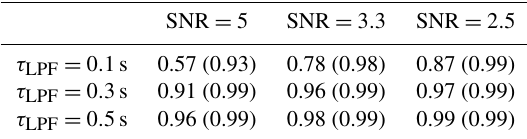
Table 1. Results of the noise removal procedure applied in the power spectra approach following Ibrom et al. (2007a) (PSA I07 ): the values indicate the slopes of the fitted line to the high-frequency end of the spectrum in Fig. 4, with the coefficient of determination ( R 2 ) shown in the parenthesis as a function of τ LPF and SNR. Note that for accurate noise removal the slopes should equal 1. SNR =